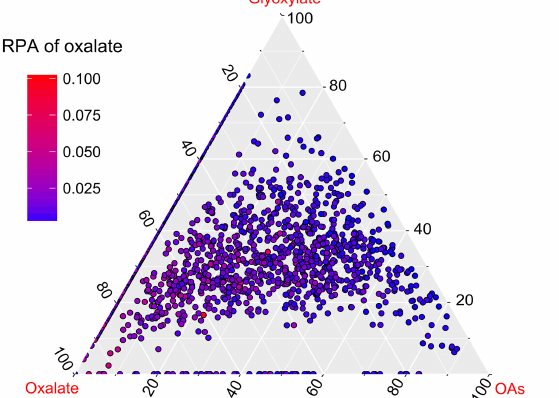
Figure 7. Box-and-whisker plots of the variations of Nfs for the K- rich, oxalate-containing, and glyoxylate-containing particles during the cloud